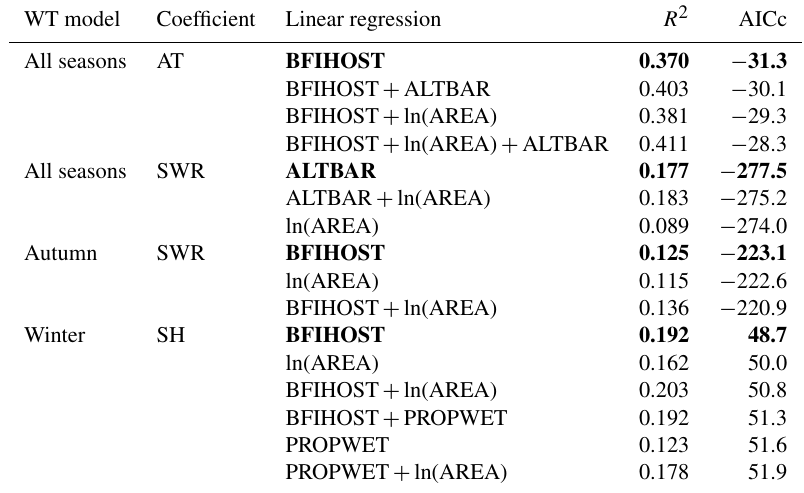
Table 5. Linear regressions of site-specific coefficients as function of basin properties (models ordered by increasing AICc; best model in bold characters, all other models are within four AICc points of best model and hence selected via